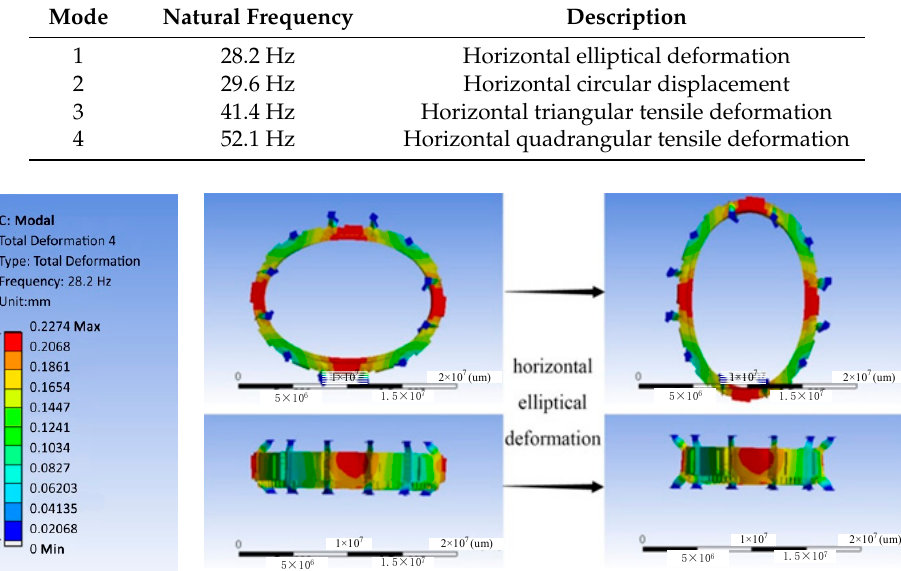
Figure 11. The first order mode-shape of the stator pack at 28.8 Hz.